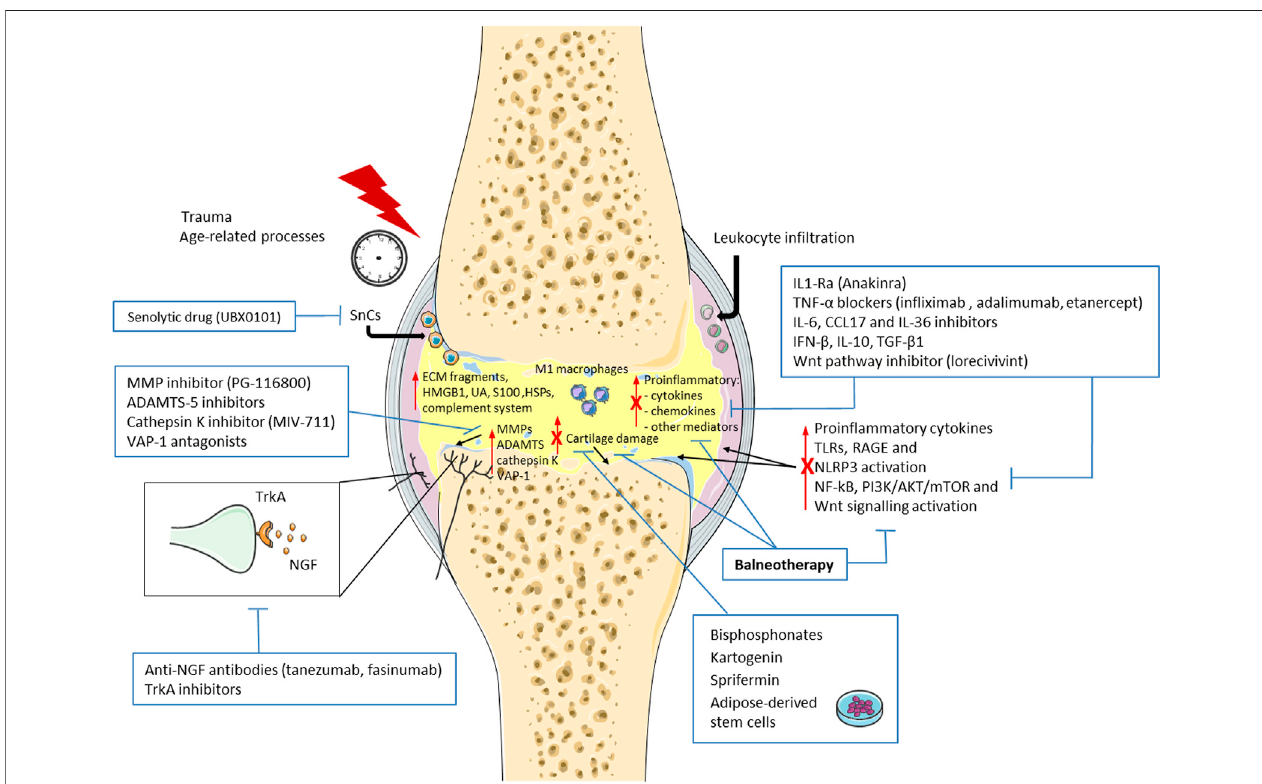
FIGURE 1 | Schematic representation of the new emerging therapies targeting immune system and immunomodulatory properties of balneotherapy in osteoarthritis(OA).Immunologicaleventsandlow-gradein fl ammationplayakeyroleinthepathogenesisandprogressionofOA.Damage-associatedmolecularpatterns (DAMPs), including extracellular matrix (ECM) fragments, high mobility box 1 (HMGB1), uric acid (UA), complement system, S100 proteins, and heat shock proteins (HSPs) are released into the joint after trauma or age-related processes. These molecules, bind Toll-like receptors (TLRs), the receptor for advanced glycation end products (RAGE) and the intracellular NLRP3 in fl ammasome, and induce the production of pro-in fl ammatory mediators, such as cytokines and chemokines. Concomitantly, leukocyte in fi ltration, presence of activate macrophages (M1) and senescent cells (SnCs), levels metalloproteinases (MMPs), A Disintegrin And Metalloproteinase with Thrombospondin motif (ADAMTS), vascular adhesion protein-1 (VAP-1) and Nerve Growth factor (NGF) are enhanced, thus promoting cartilage damage and pain. Finally, NF-kB, PI3K/AKT/mTOR, and Wnt/ β -Catenin signaling pathways are activated in these processes. New emerging treatment and balneotherapy have demonstrated a decrease in OA progression through immunomodulatory properties. ↑ increase; T inhibition; X reduction by balneotherapy.